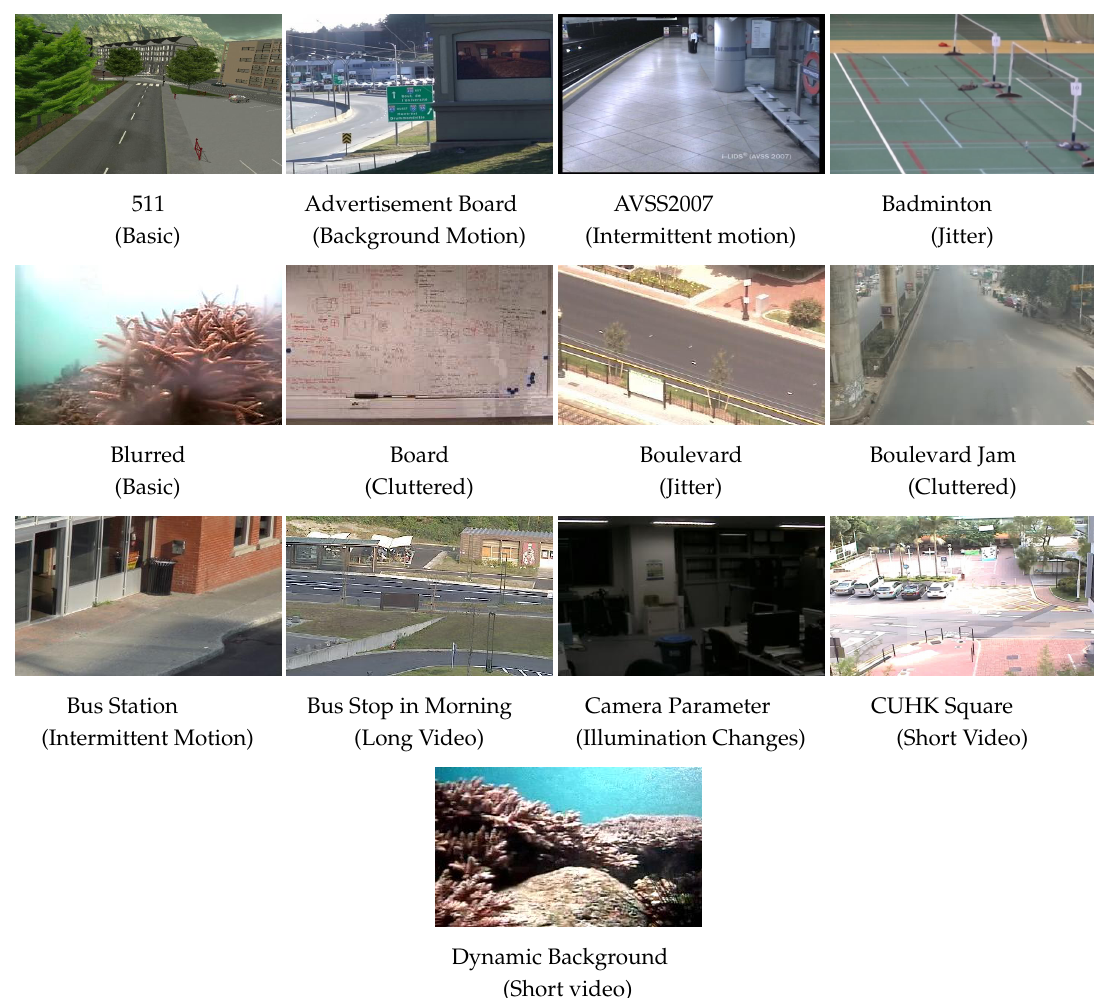
Figure 2. Reference background images for different scenes in the SBMNet based Reconstructed Background Quality (S-ReBaQ) Dataset. Each reference background image corresponds to a captured scene background without foreground